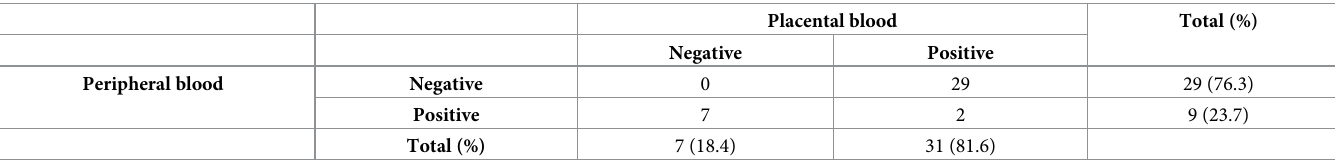
Table 9. Paired peripheral and placental samples of all P . malariae involved